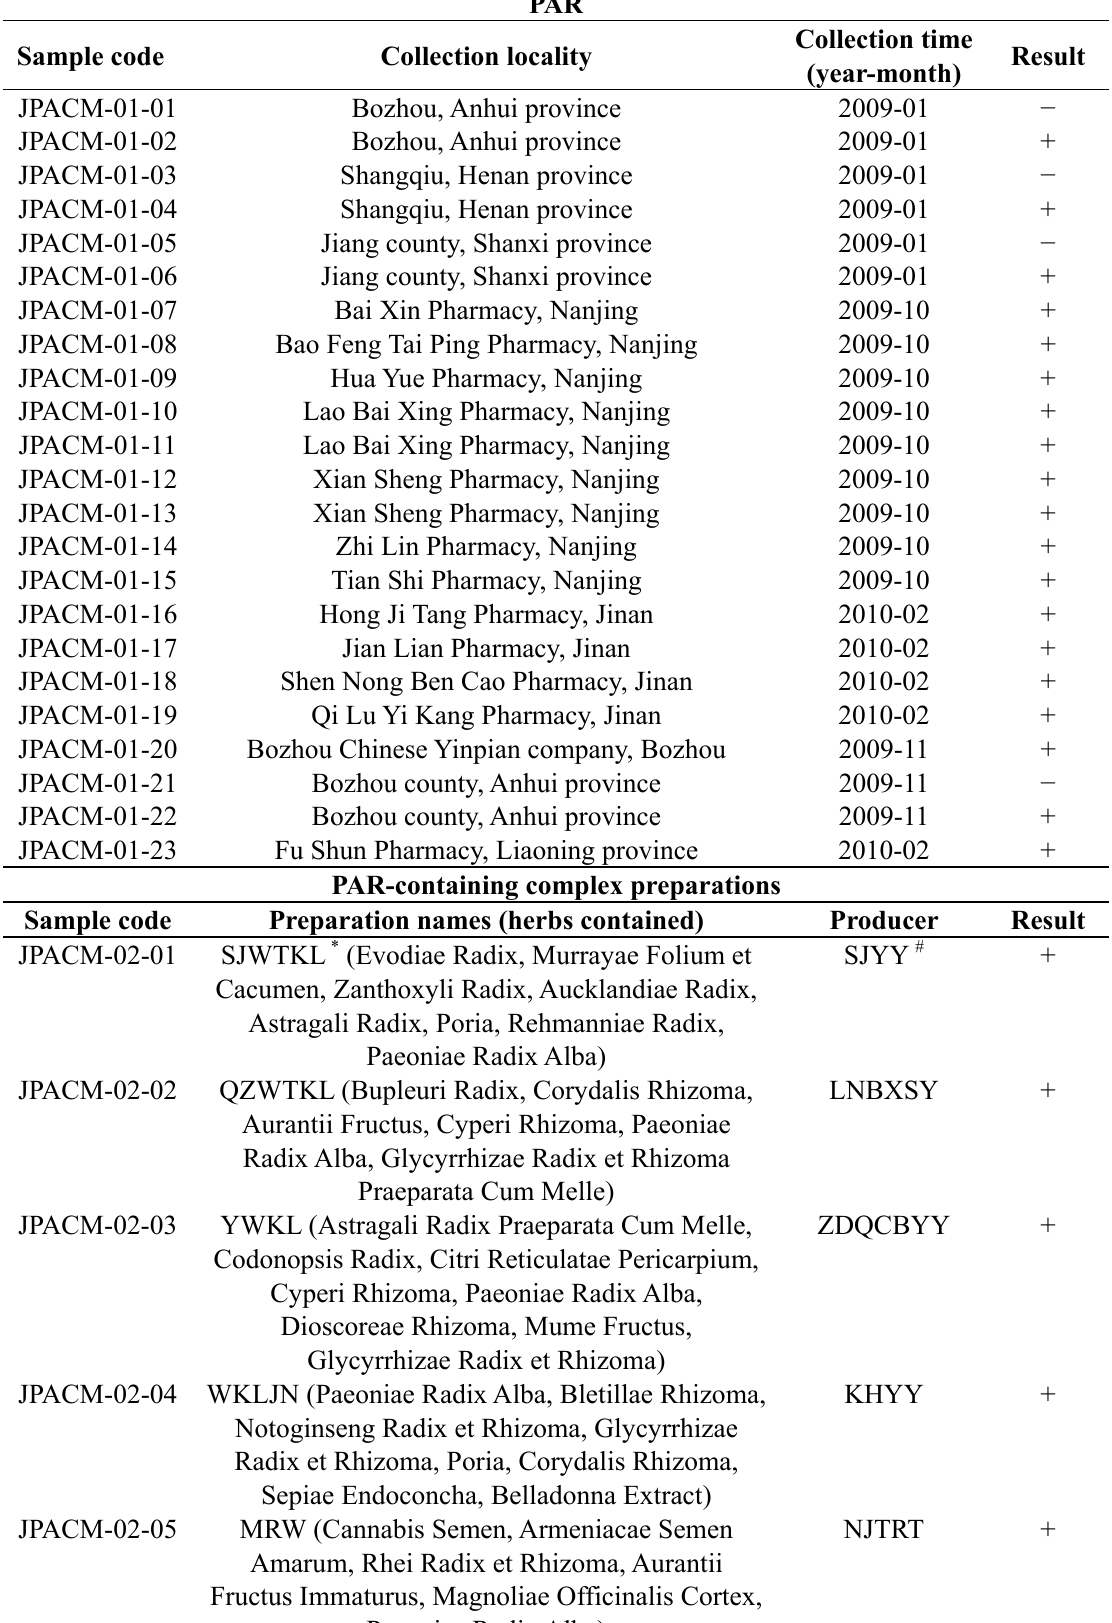
Table 1. Detection of paeoniflorin sulfonate in PAR and PAR-containing complex preparations.